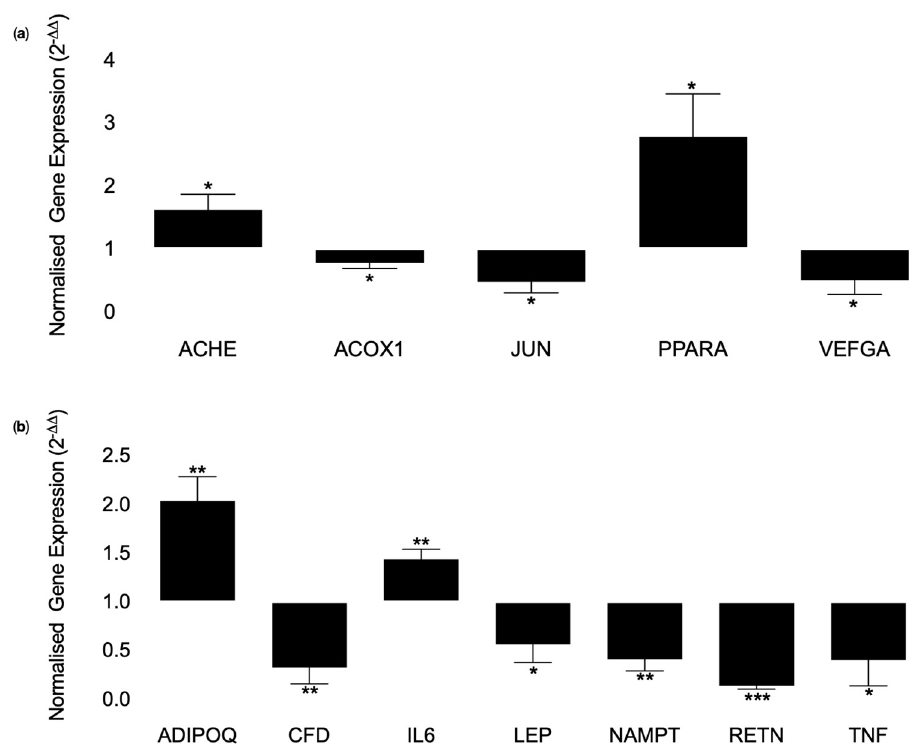
Figure 4. mRNA expression of genes known to be dysregulated in obesity in response to acute AC2-26 treatment using a human adipocyte model mimicking the inflammatory status observed in obesity. Simpson Golabi Behmel Syndrome (SGBS) cells were differentiated into mature adipocytes and treated with 10 µ M AC2-26 or vehicle control and incubated in hypoxia (1%O 2 ) environment for 24 h. mRNA was extracted using Trisure and cDNA was synthesized. 80 ng of cDNA was used in SYBR green mediated quantitative PCR. Ct values were obtained and used to calculate normalized gene expression using the Livak 2 − ∆∆ CT equation. One-tailed unpaired student’s t -test was used to statistically analyse the data. ( a ) Genes involve in adipocyte development; ACHE ( p = 0.0317, n = 3) and PPARA (0.0303, n = 3) were significantly upregulated, whereas, ACOX1 ( p = 0.0303, n = 3), JUN